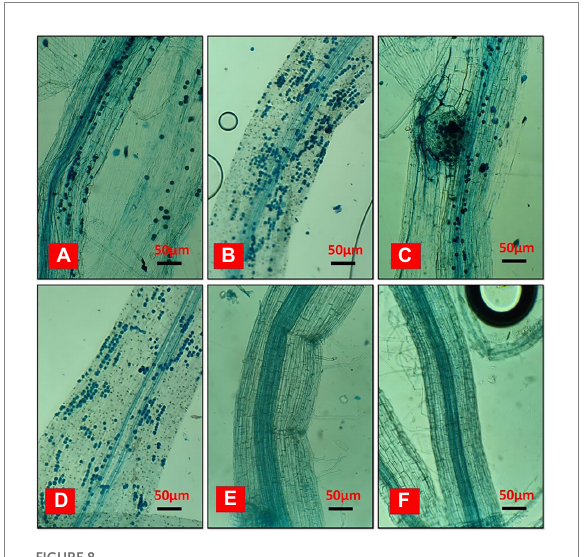
FIGURE 8 The effects of biosustained spores of Trichoderma isolates on the colonization of Serendipita indica in rice roots under accumulated field conditions of Eucalyptus leaves. (A) T1-TI04 (78.12%); (B) T2-TI04 (86.36%); (C) T3-TI15 (77.22%); (D) T4-TI15 (83.16%); (E) T5-Control (0%); (F) T6-Control